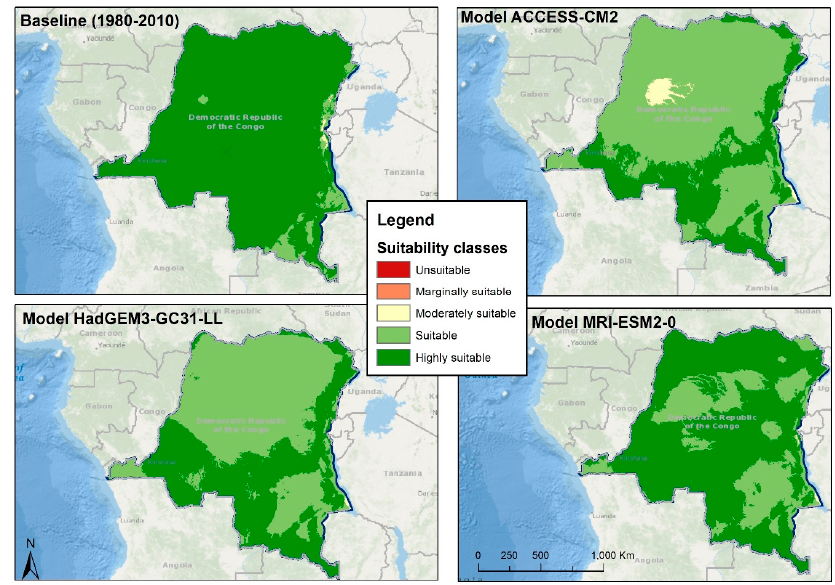
Figure 2. Cassava climate suitability under climate change conditions (ssp585) for 2061–2080 in DRC. Predicted Climate Suitability for Maize under Climate Change Conditions in DRC. Suitability analysis based on climate data shows that the southern regions, i.e., for- mer provinces of Katanga, Kasaï, Bandundu, Bas-Congo, and some parts of the east and north-east are suitable for maize production. A large part of the country remains moder- ately suitable for maize. However, the result of climate change projection in extreme con- ditions (ssp585 or RCP 85) shows that DRC will lose its maize production potential and its suitable areas will be converted into moderately suitable ones in most cases (Figure 3). As a result, there will be a significant increase in marginally suitable lands with climate change. Maize sensitivity to temperature and precipitation are high and proven by several authors, and therefore, it is a highly susceptible crop to climate change [21]. This situation will accelerate farmers’ vulnerability to climate change due to the direct negative impacts of climate change on the suitability and productivity of crops they rely on for both sub- sistence and income.